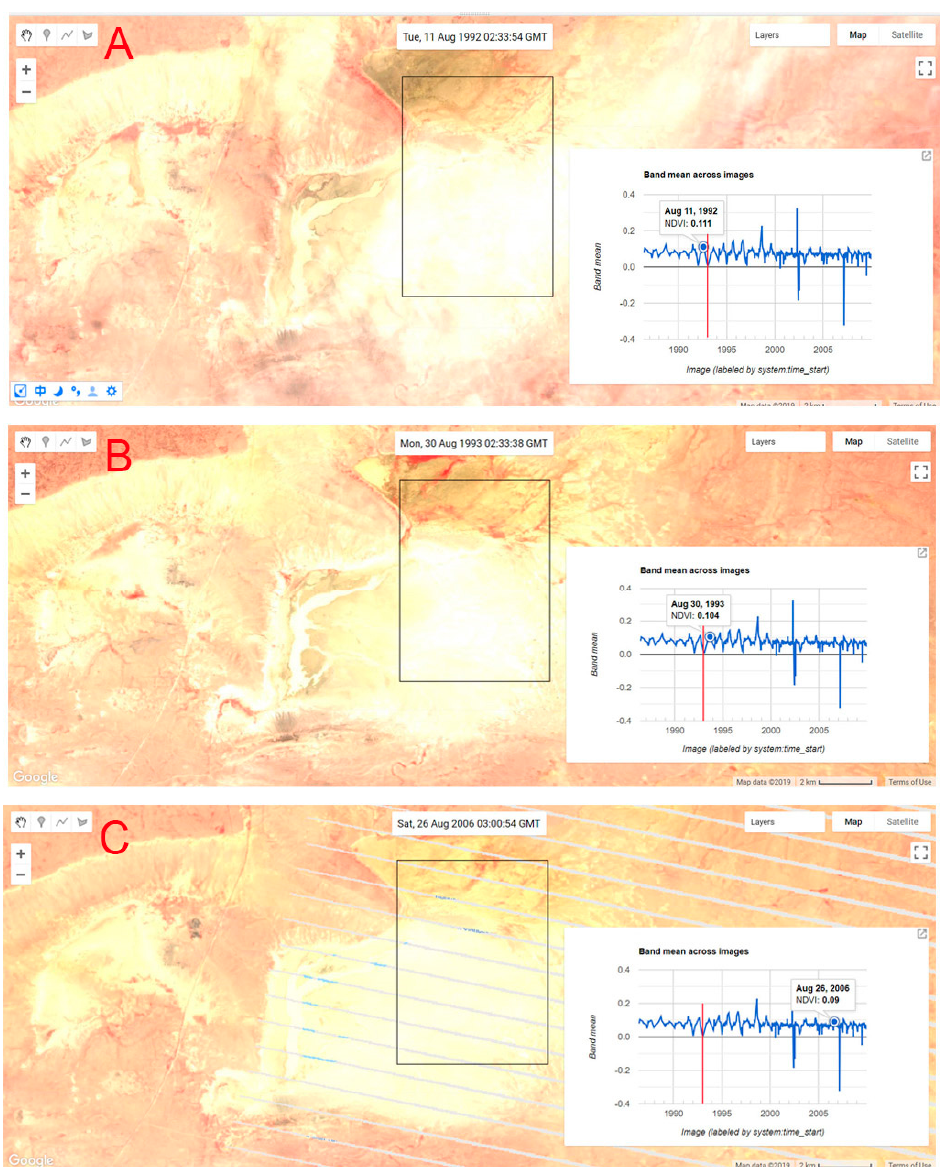
Figure 9. A breakpoint example validated in GEE for the same place as in Figure 8. All the images were acquired in August. The polygon boundary (black box) marks the approximate extent of the NDVI GIMMS pixel. The break year was detected by TSS-RESTREND in 1993 marked with a red line in the NDVI time series chart. The combination used to create RGB composites of Landsat images are Near Infrared, Red, and Green. The decrease of NDVI and degraded vegetation could be observed in the time series images.